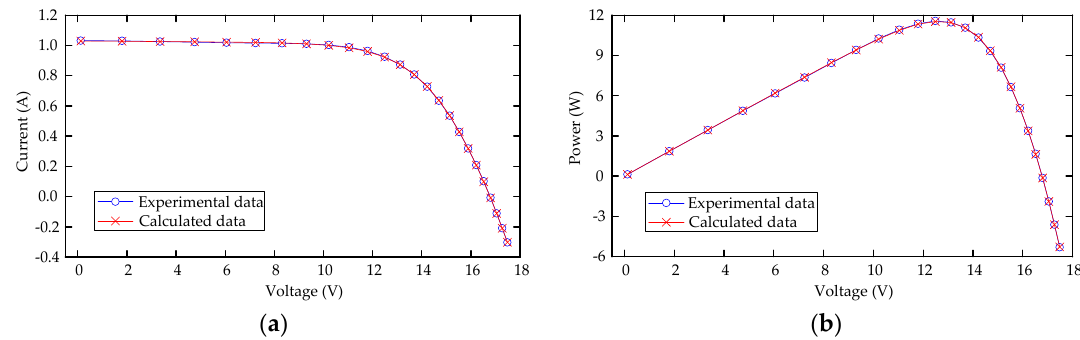
Figure 9. Comparisons between the experimental data and calculated data obtained by the proposed ImCSA for the PMM of Photowatt-PWP201 module: ( a ) I-V characteristics; ( b ) P-V characteristics.